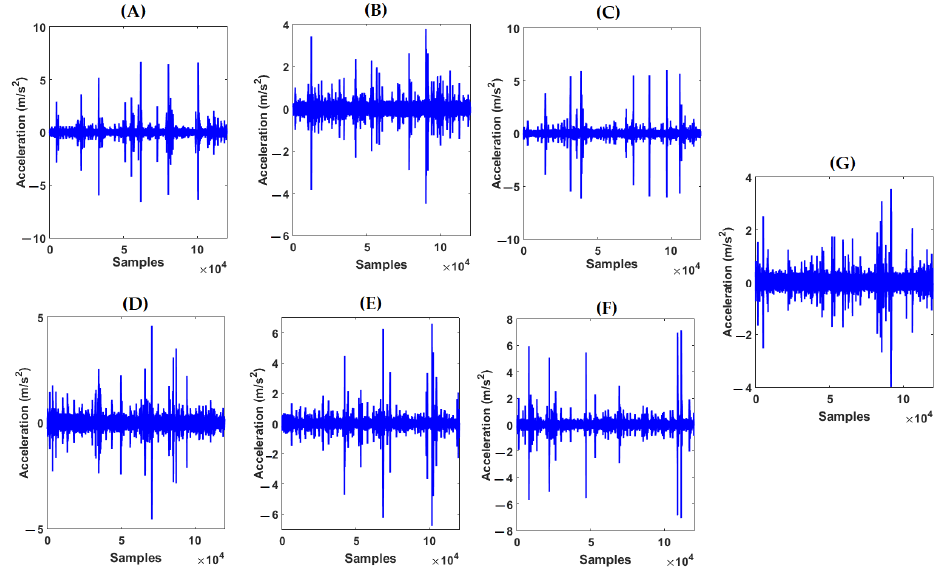
Figure 7. Acoustic emission original abnormal signals: ( A ) ball condition, ( B ) outer condition, ( C ) inner condition, ( D ) inner–outer condition, ( E ) inner–ball condition, ( F ) outer–ball condition and ( G ) inner–outer–ball condition.